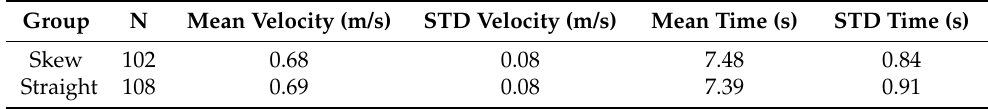
Table 1. Information on the number of participants and the mean and standard deviation (STD) of velocity (m/s) and time (s) for each